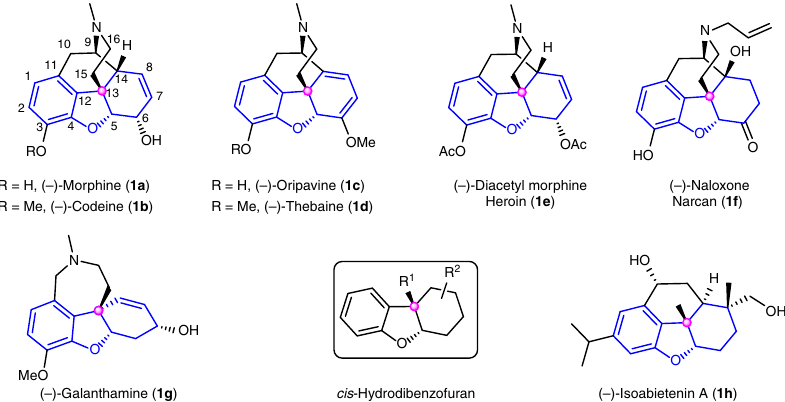
Fig. 1 Representative natural products and derivatives containing a cis -hydrodibenzofuran framework. The strained cis -hydrodibenzofuran skeleton bearing an all-carbon quaternary stereocenter is widely found in bioactive natural products and drugs. These natural products and drugs ( 1a , 1b , 1f , and 1g ) have exhibited prominent biological activities and